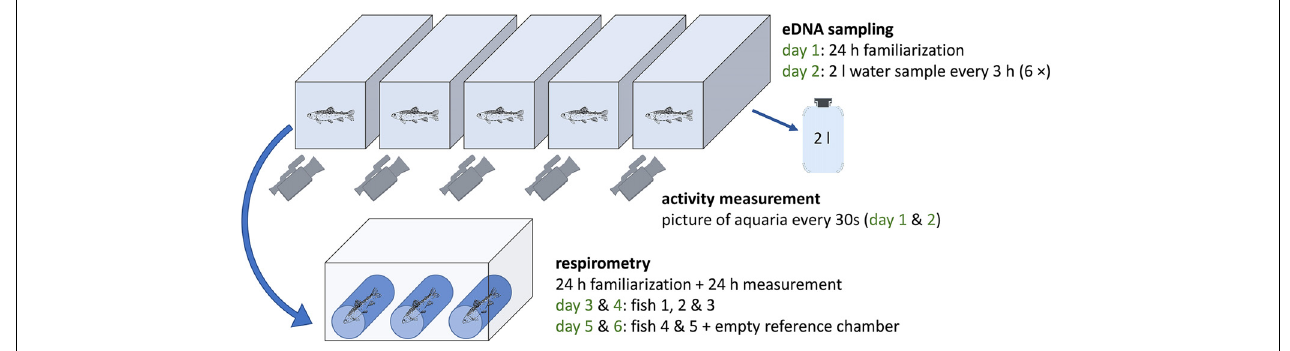
FIGURE 2 | The setup of the aquarium experiment carried out with seven fish species: five individual fish were put in fish tanks for water sampling (eDNA) and activity recordings (days 1 and 2) followed by respirometer measurements (three individuals on days 3 and 4; two individuals plus empty control chamber on days 5 and 6). For Phoxinus phoxinus and Squalius cephalus the experiment was repeated using groups of three individuals per tank and respirometer